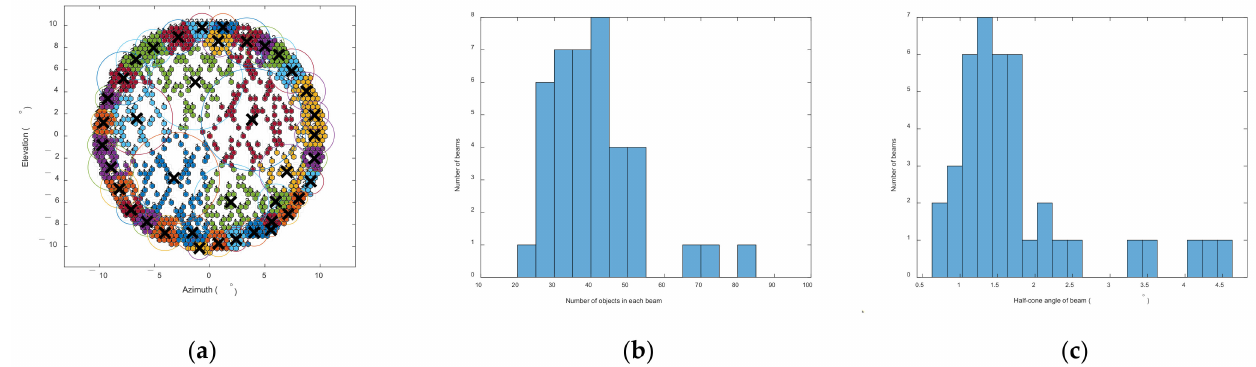
Figure 8. Optimization results of the beam allocation based on the modified K-means clustering when parameter α equals 0 and β equals 0: ( a ) Plot of the allocated 40 beams. The crossing indicates the geometrical center of each beam. The neighboring hexagonal cells in the same beam are marked with the same color; ( b ) Statistics of the beam occupation; ( c ) Statistics of the beam width.